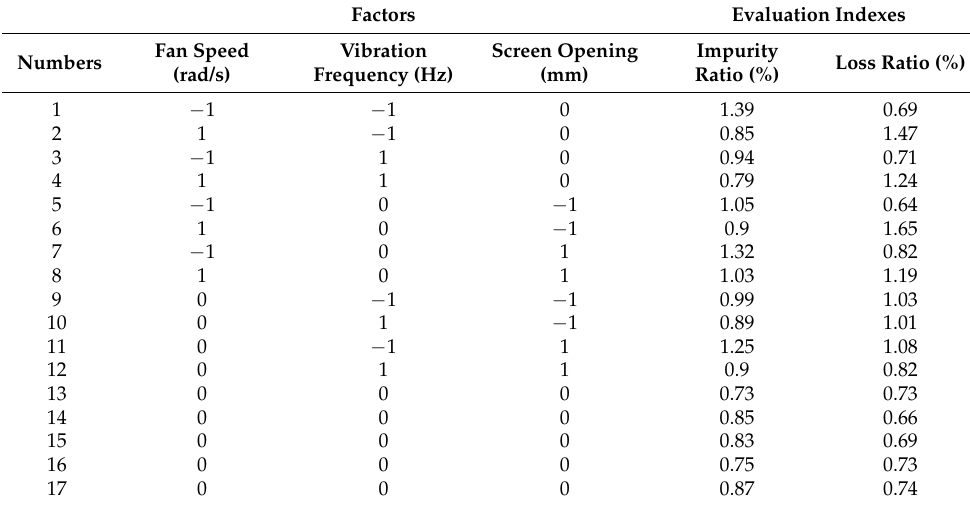
Table 3. The experimental design and